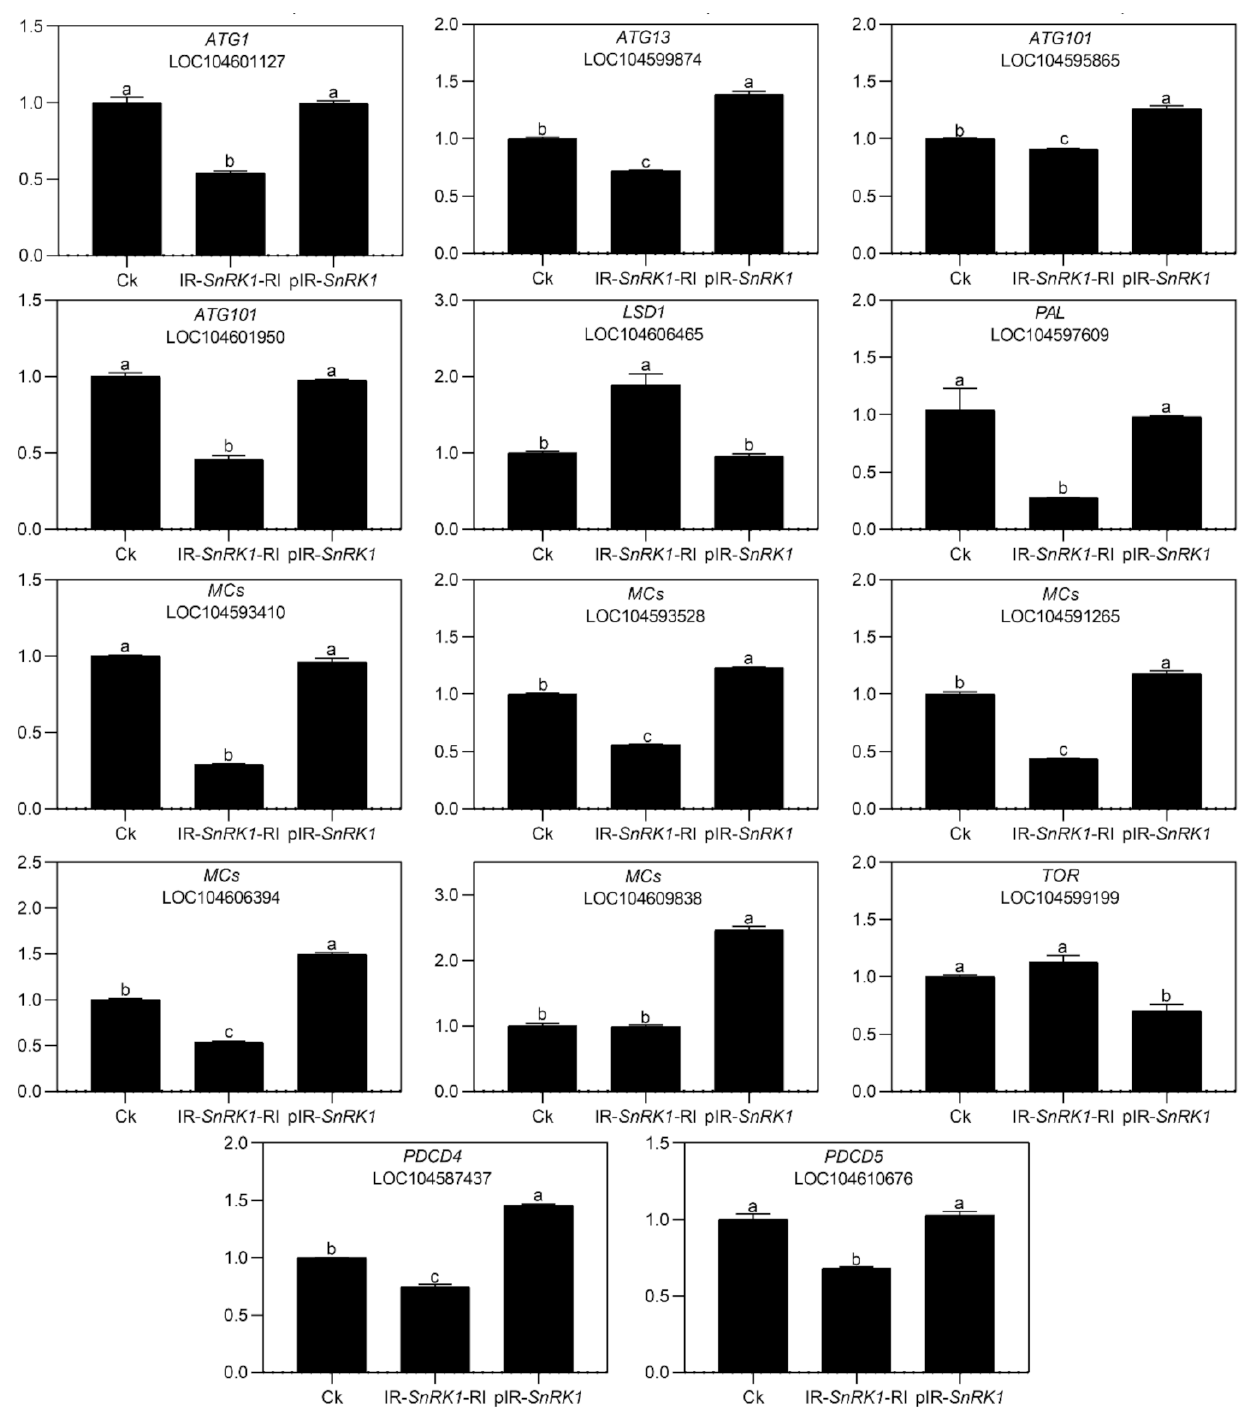
Figure 7. Expression analysis of autophagy- and programmed cell death (PCD)-related genes in the lotus. Two-month- old lotus seedlings were used for infection with IL-60-BS-derived systems. IR- NnSnRK1 -RI, NnSnRK1 -silenced lotus; pIR- NnSnRK1 , NnSnRK1 -overexpressed lotus. After 14 days of infection, the gene expression level was analyzed using quantitative real-time reverse transcriptase-polymerase chain reaction (qRT-PCR). Values are the means ± SE of three independent experiments with at least three replicates for each. Bars marked with different letters are significantly different from each other at p < 0.05, according to Tukey’s multiple